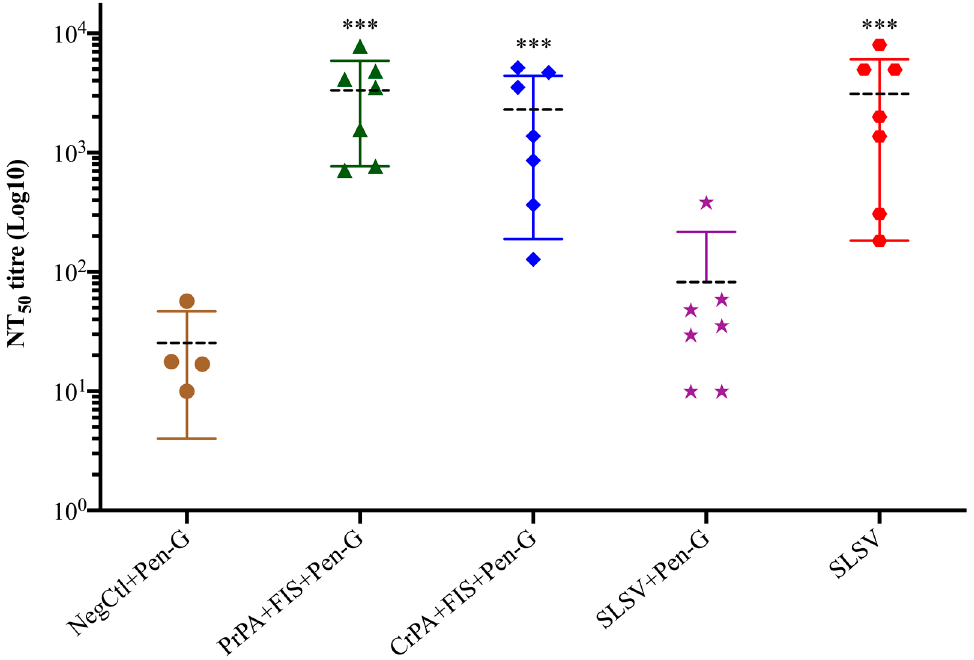
Figure 6. Lethal toxin neutralising titres at week 5 in vaccinated cattle. The cattle were vaccinated twice (weeks 0 and 3) with PrPA + FIS + Emulsigen-D ® /Alhydrogel ® plus Pen-G ( n = 7), CrPA + FIS + Emulsigen-D ® / Alhydrogel ® plus Pen-G ( n = 7), with SLSV plus Pen-G ( n = 7), and SLSV ( n = 7), and the naïve control consisting of Emulsigen-D ® / Alhydrogel ® plus Pen-G (NegCtl) ( n = 4) received the vaccine diluent and Pen-G on weeks 0 and 3. NT 50 of each group were compared to the respective titres at week 0 before vaccination (*** p < 0.001, ** p < 0.01, * p ≤ 0.05). Purified recombinant protective antigen: PrPA; Crude recombinant protective antigen: CrPA; Formalin inactivated Bacillus anthracis spores: FIS; Penicillin-G: Pen-G; Sterne live spore vaccine: SLSV; Negative control: NegCtl.